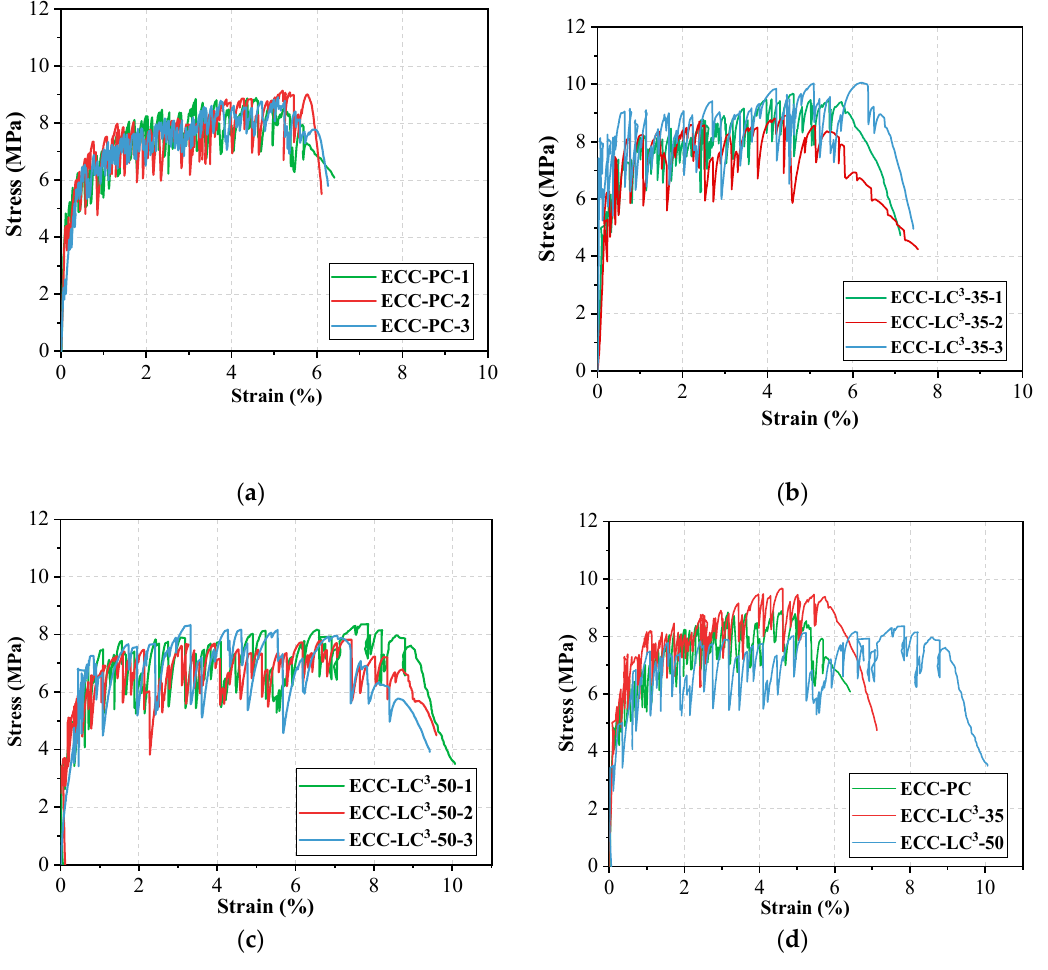
Figure 10. Tensile stress-strain curves of the three types of ECC: ( a ) ECC-PC; ( b ) ECC-LC 3 –35; ( c ) ECC-LC 3 –50; ( d ) representative curve.